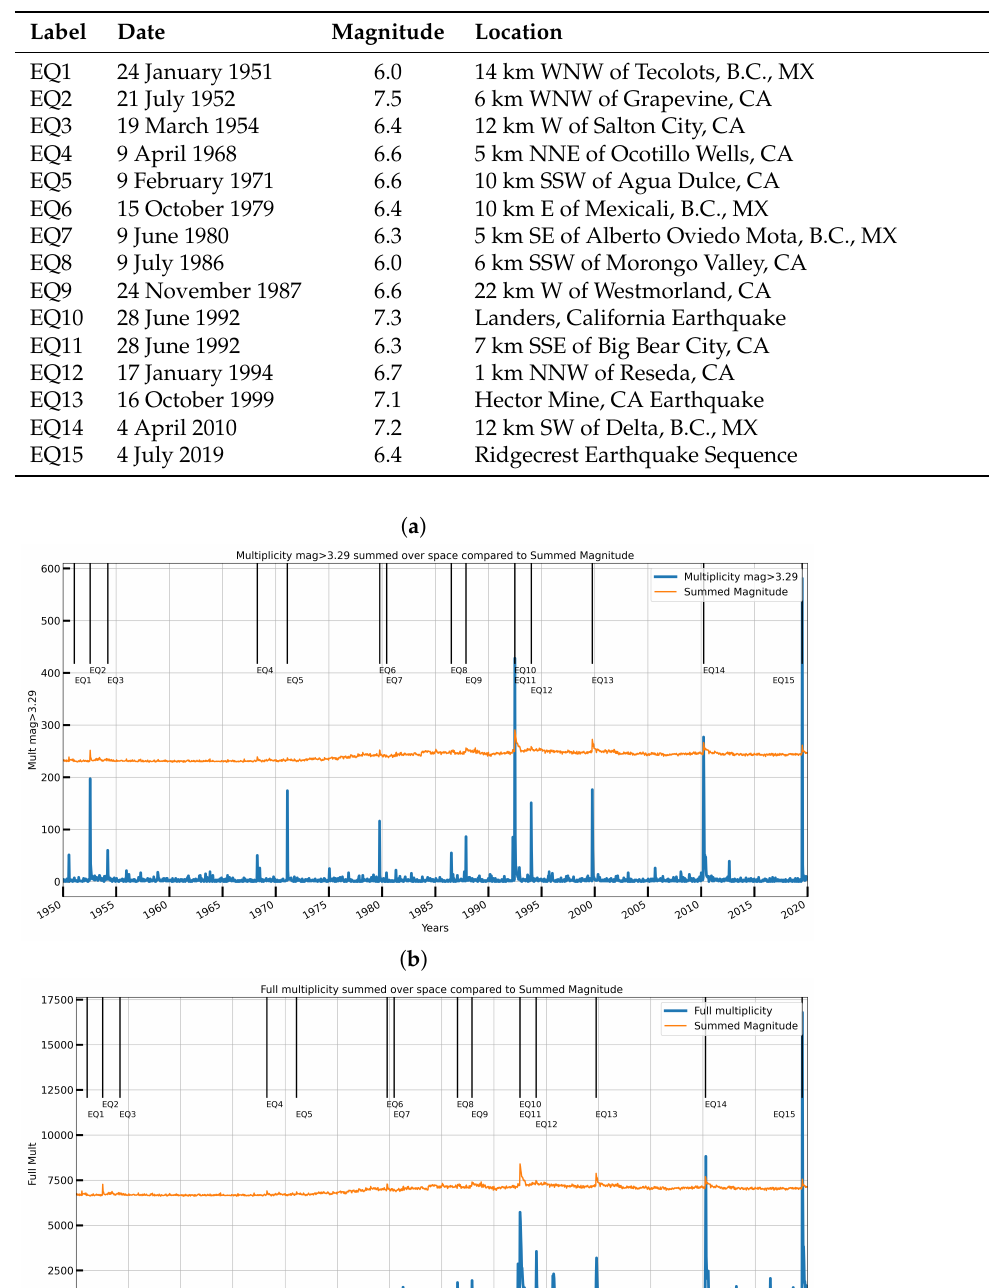
Table 1. Fifteen earthquakes from the earthquake catalog data [38] shown in plots.